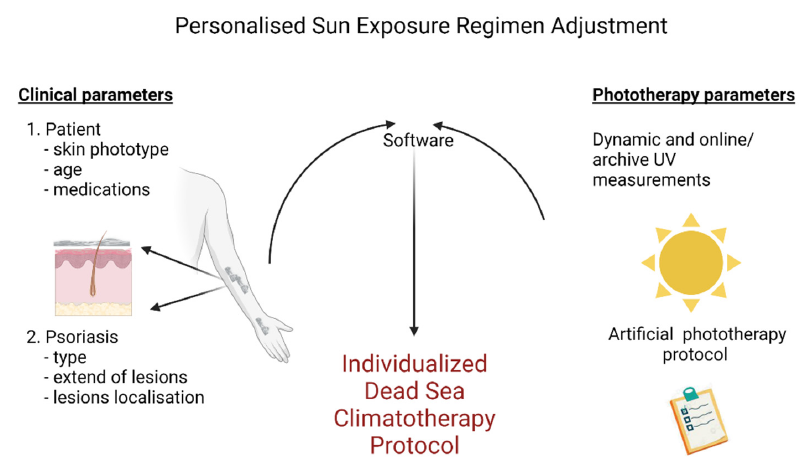
Figure 5. Dead Sea personalized climatotherapy protocol. Created with BioRender.com.